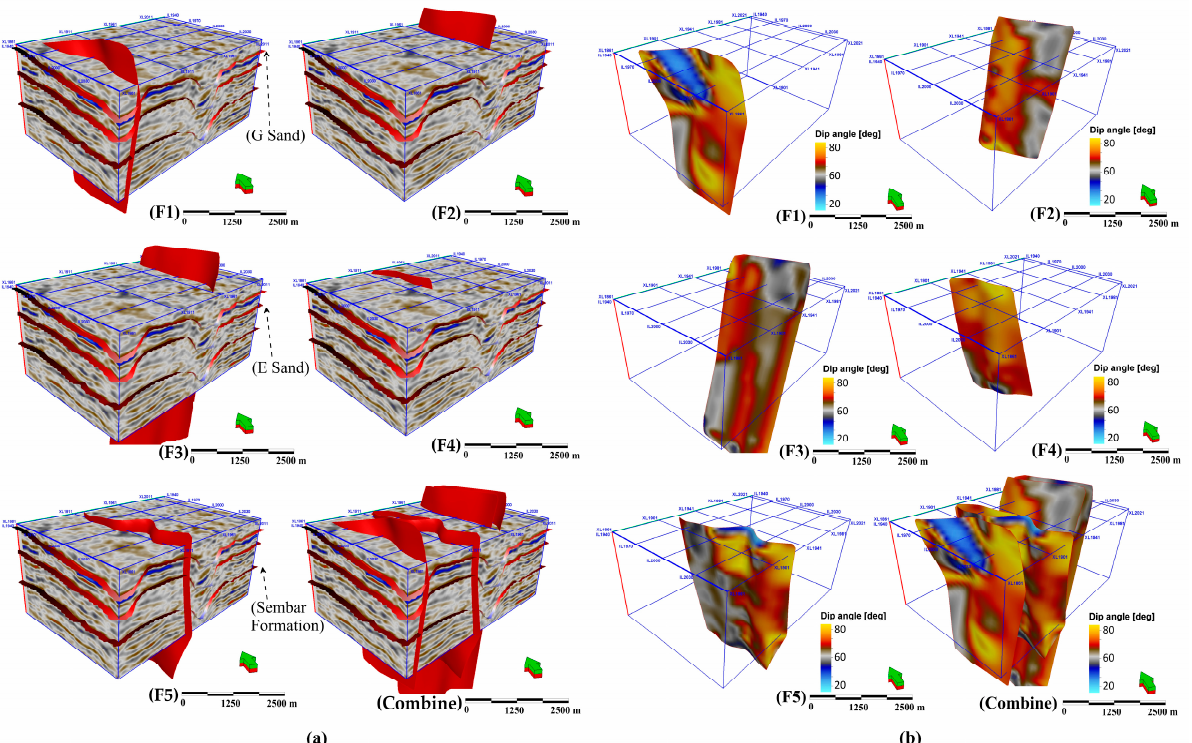
Figure 8. ( a ) The individual and combined distribution of tectonic extensional fault surfaces along the early Cretaceous stratigraphic sequence in the 3D seismic volume (SW-SE) and ( b ) 3D dip angle models (SW-SE) of the individual and combined tectonic extensional fault